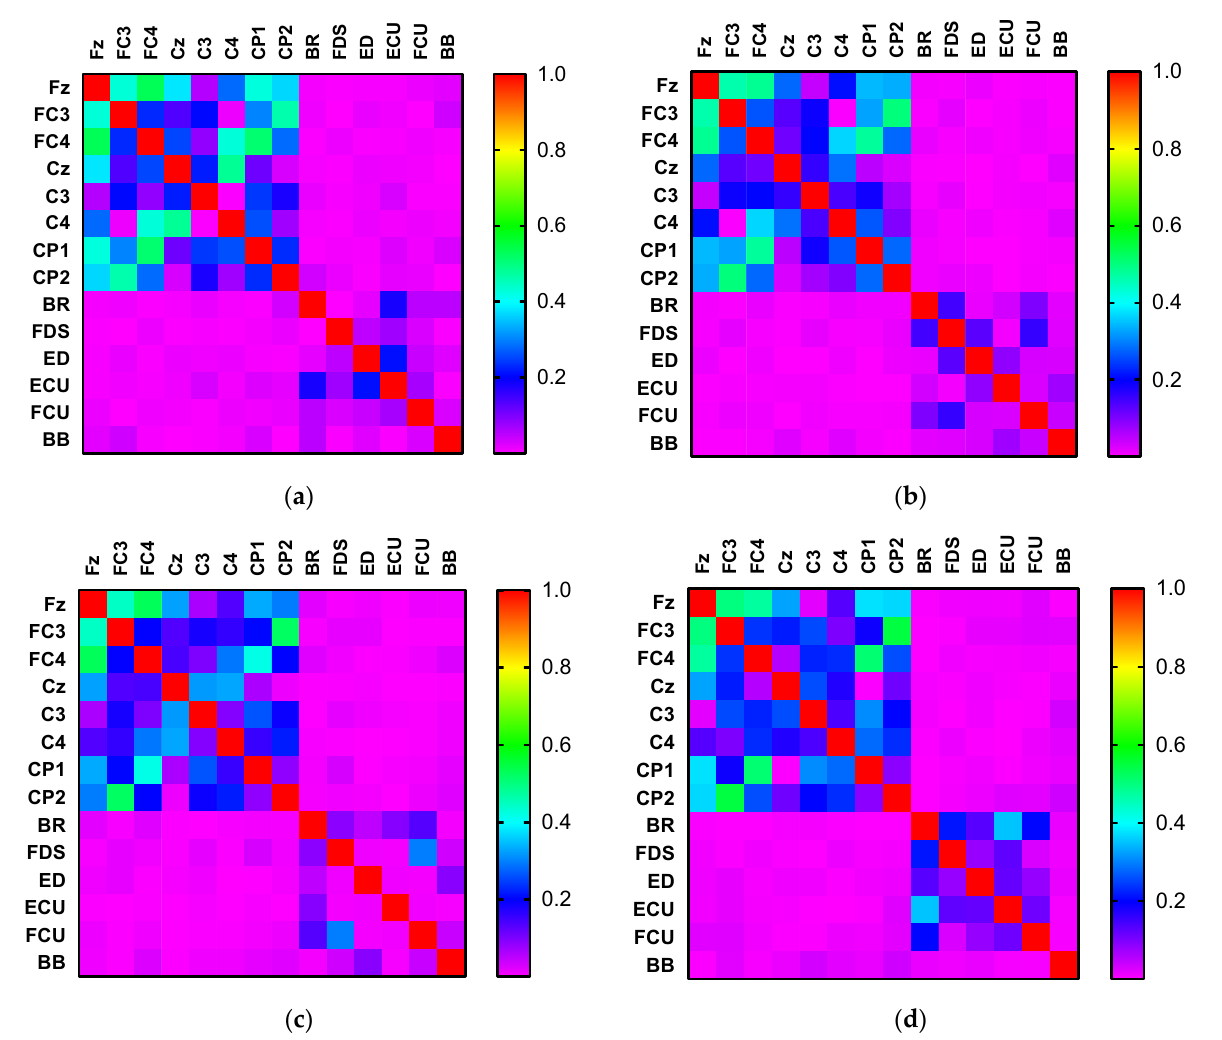
Figure 4. Heatmaps of the Kendall rank correlation coefficient of the EEG and EMG signals corre- sponding to ( a ) hand open, ( b ) hand closed, ( c ) wrist flexion, and ( d ) wrist extension. To evaluate the significant correlation difference for the different activities, we con- ducted a one-way analysis of variance (ANOVA). To evaluate the significant correlation difference for the different activities, we performed one-way ANOVA for each of the four conditions (C3-FDS, C3-ED, C3-ECU, and C3-FCU). After the normality test of the data, the different activities (HO, HC, WF, and WE) were independent variables, and the corre- lations of C3-FDS, C3-ED, C3-ECU, and C3-FCU for these activities were the dependent variables for a one-way ANOVA. The results for C3-FDS, C3-ED, C3-ECU, and C3-FCU are shown in Figure 5. ( p < 0.05). Significant differences in activity of C3 ‐ FD, C3 ‐ ED, C3 ‐ ECU, and C3 ‐ FCU were (F(3956) = 3.012, p = 0.0293), (F(3956) = 5.57, p = 0.00086), (F(3956) = 7.284, p = 0.000078) and